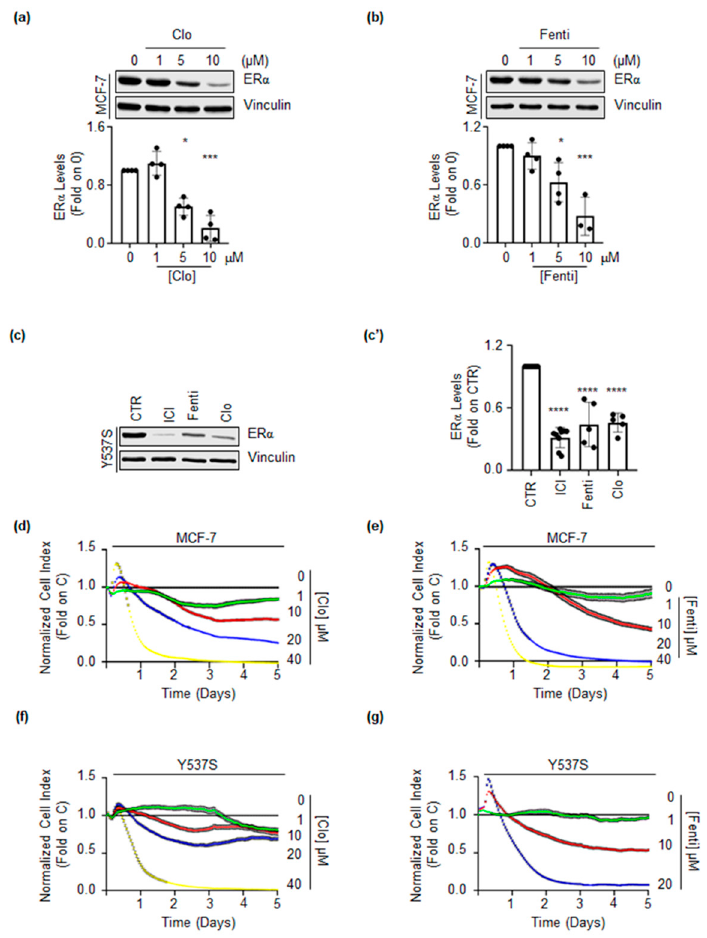
Figure 3. Clotrimazole and fenticonazole effect on ER α levels and cell proliferation. ( a , b ) Western blotting and relative densitometric analyses of ER α cellular levels in MCF-7 cells treated with different doses of clotrimazole (Clo) ( a ) and fenticonazole (Fenti) ( b ) for 72 h. The loading control was done by evaluating vinculin expression in the same filter. The experiment was performed in triplicate. Significant differences with respect to 0 sample are calculate by Student t-test and indicated by * ( p -value < 0.05), *** ( p -value < 0.001) . Western blotting ( c ) and relative densitometric analyses ( c’ ) of ER α cellular levels in Y537S cells treated with clotrimazole (Clo 10 μ M) and fenticonazole (Fenti 10 μ M) for 72 h. The experiment was performed in triplicate. Significant differences with respect to 0 samples are calculated by the Student t-test and indicated by **** ( p -value < 0.0001) . Growth curve analyses in MCF-7 ( d , e ) or in Y537S ( f , g ) were performed as indicated in the material and method section for 5 days with the indicated doses (color lines) of clotrimazole (Clo) ( d , f ) or fenticonazole (Fenti) ( e , g ). Experiments were done twice in quadruplicate.